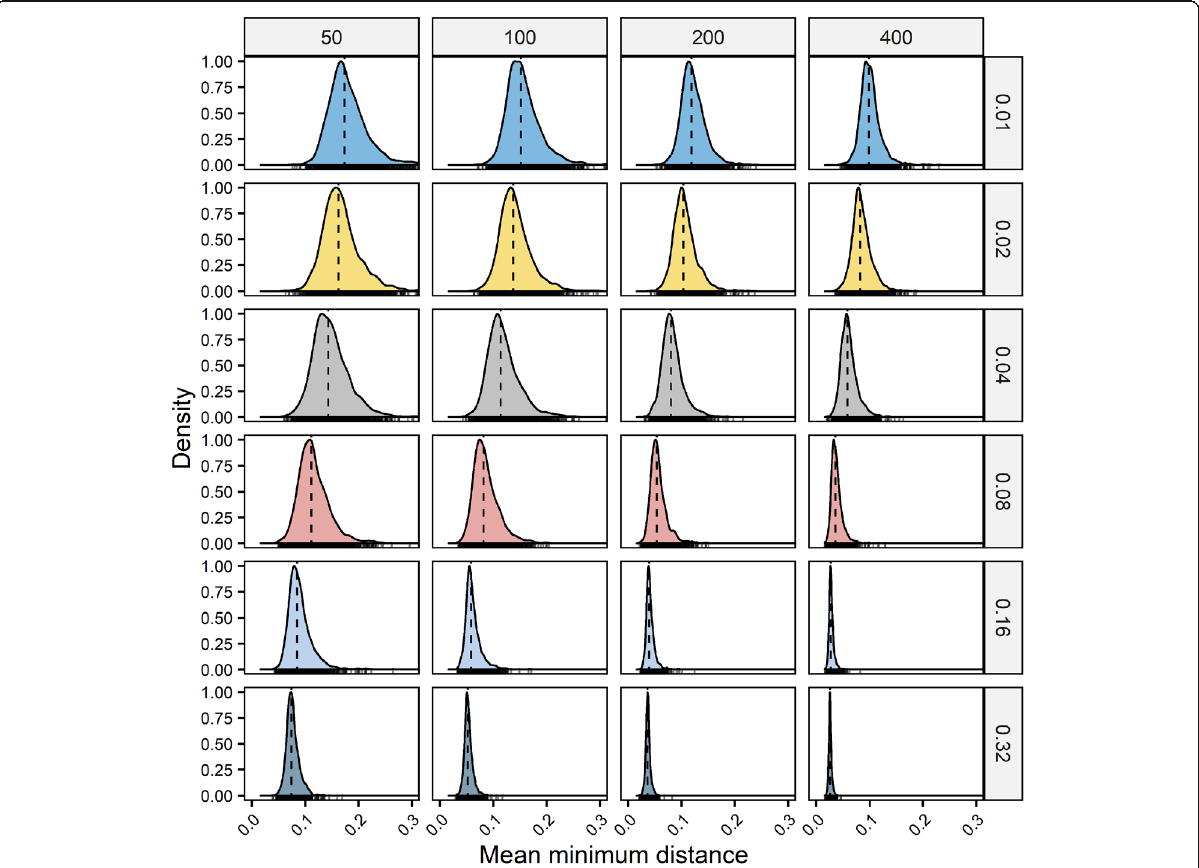
Fig. 1 The density of the mean distance between a single pathogen propagule and its nearest BCA propagule in a given simulation run for each combination of biocontrol abundance (50, 100, 200, 400) and aggregation (0.01, 0.02, 0.04, 0.08, 0.16, 0.32) in a homogeneous simulation area. The dashed line indicates the median